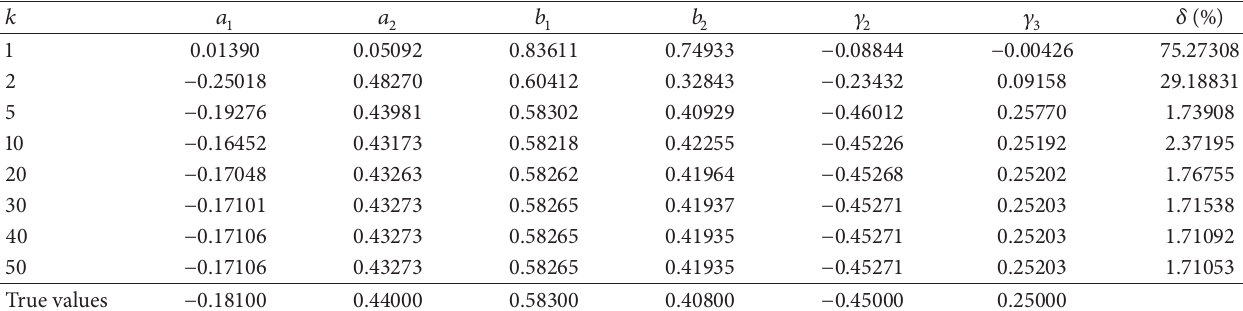
Table 1: The parameter estimates ( 𝑎 𝑖 ,𝑏 𝑖 , 𝛾 𝑖 ) and their errors ( 𝜎 2 = 0.10 2 ).